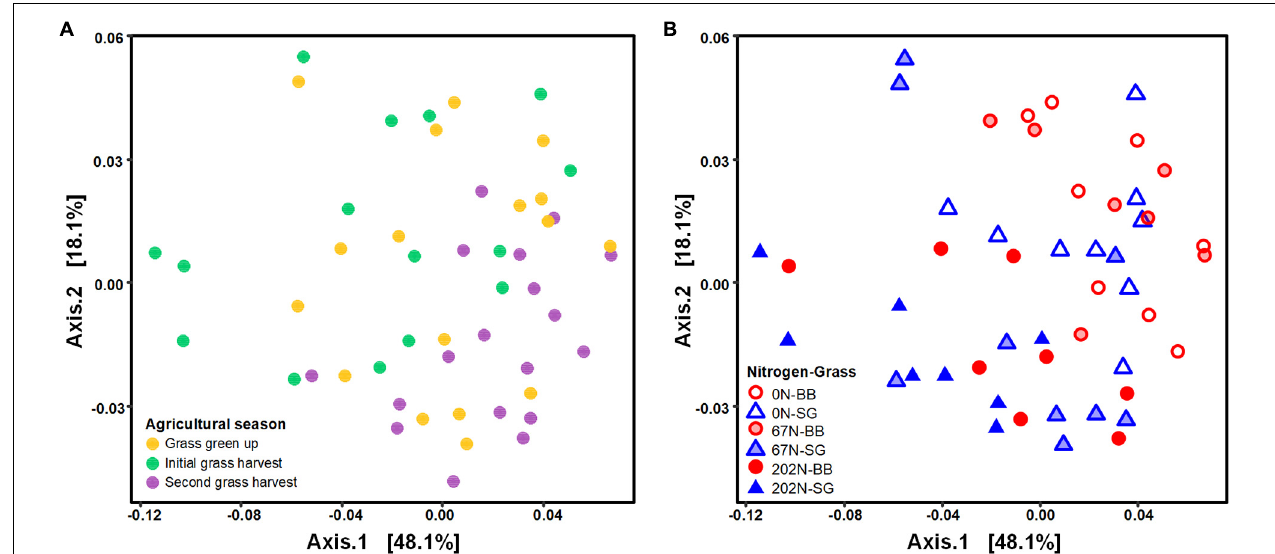
FIGURE 4 | Principal coordinates analysis (PCoA) of weighted-UniFrac distances between diazotrophic microbial communities colored by agricultural season (A) and the combination of N rate and grass species (B) . 0N, no N fertilization; 67N, 67 kg N ha − 1 fertilization; 202N, 202 kg N ha − 1 fertilization; SG, switchgrass; BB, big bluestem.